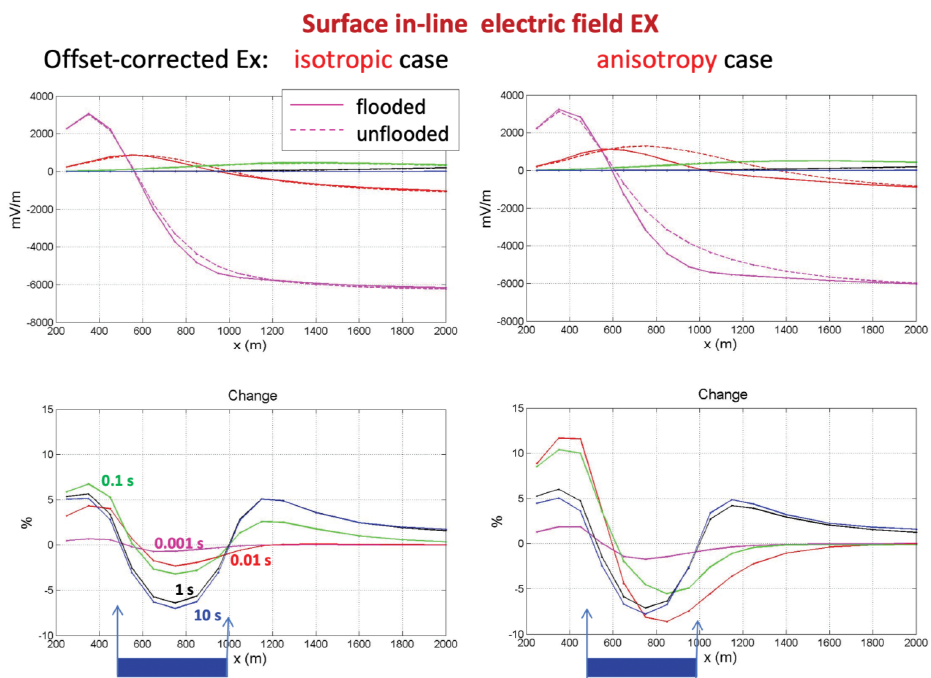
Figure 17. Simplified geologic model of a heavy oil (HO) reservoir. The HO section is the reservoir shown here as salt water saturated.